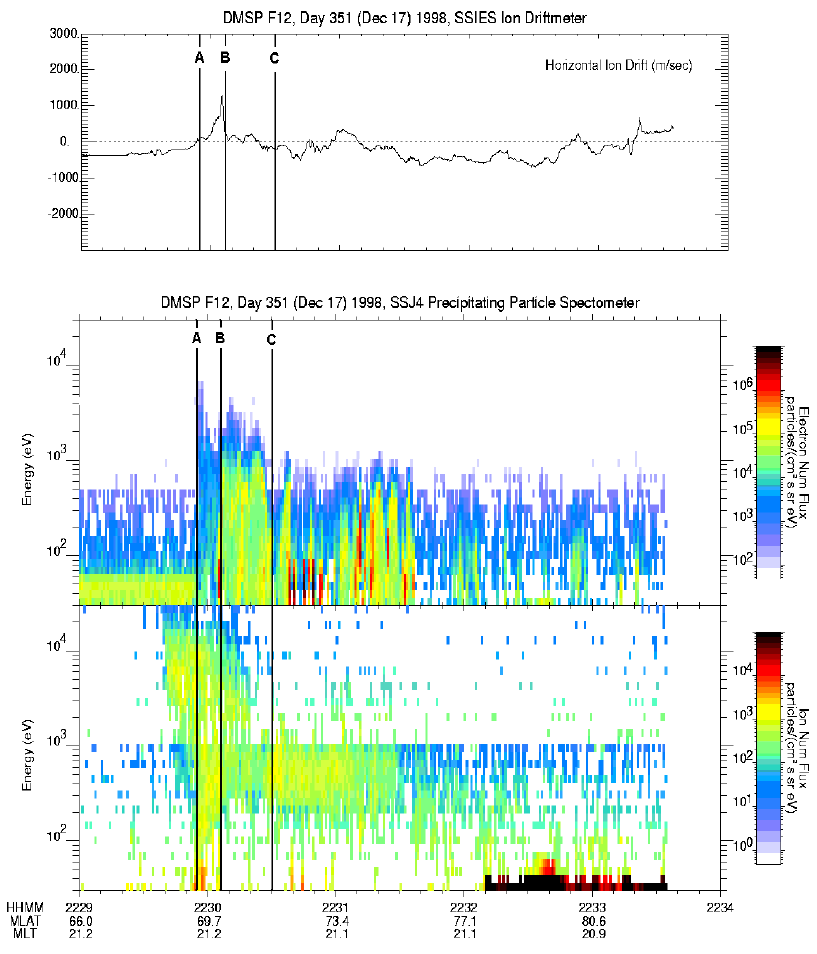
Fig. 5. The DMSP-F12 data: (top) Hor- izontal component of the ion velocity; (middle) Electron spectrogram; (bot- tom) Ion spectrogram. Vertical lines separate the different plasma popula- tions: CPS between A and B, BPS be- tween B and C, and magnetospheric boundary layers at latitudes above